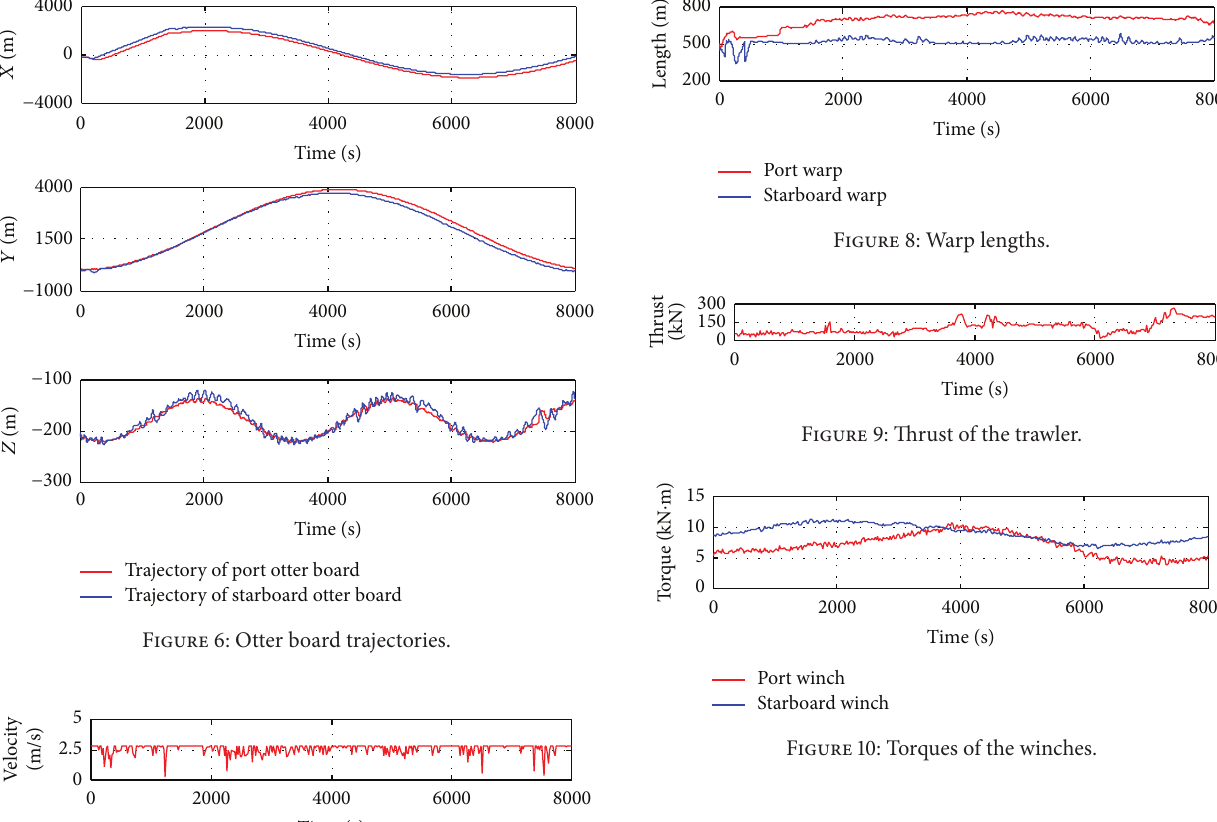
Figure 8: Warp lengths.